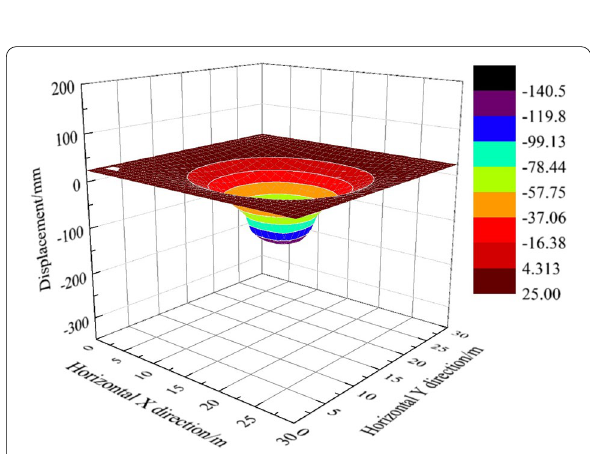
Fig. 15 Seismic subsidence of ground surface due to 0.30 g Kobe ground motion (full